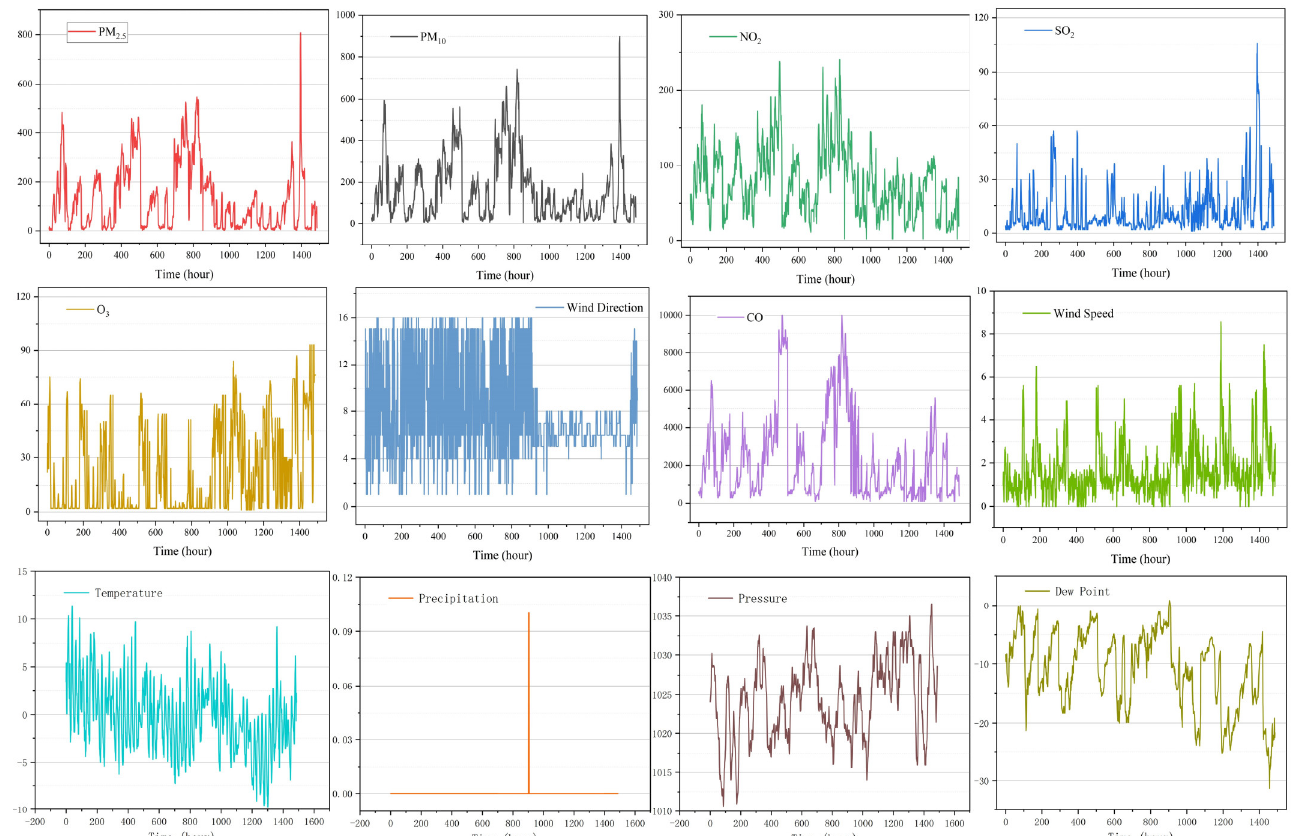
Figure 3. Time series plots of factors of influence. Table 1. Input variables for PM 2.5 concentration forecasting